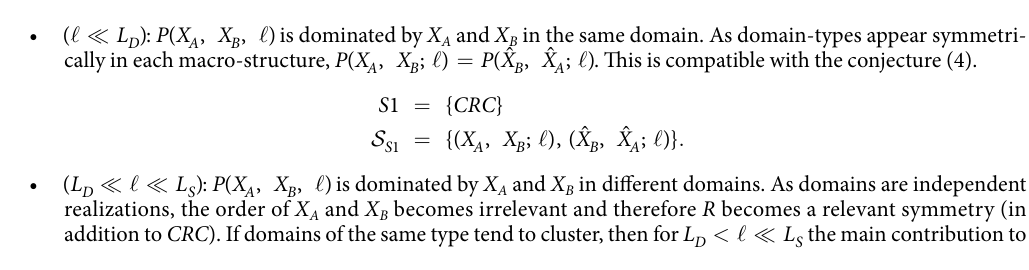
Figure 3. Hierarchy of symmetries in Homo Sapiens - Chromosome 1. [ Upper panel ] The symmetry index I ( ) as a function of the scale  , the smaller the value the larger the importance of the symmetry. [ Bottom panel ] The color bars helps visualise the onset of the different symmetries: symmetry is considered present if 0 ≤ I S ≤ 0.025 and bar is (linearly interpolated) from full color to white,